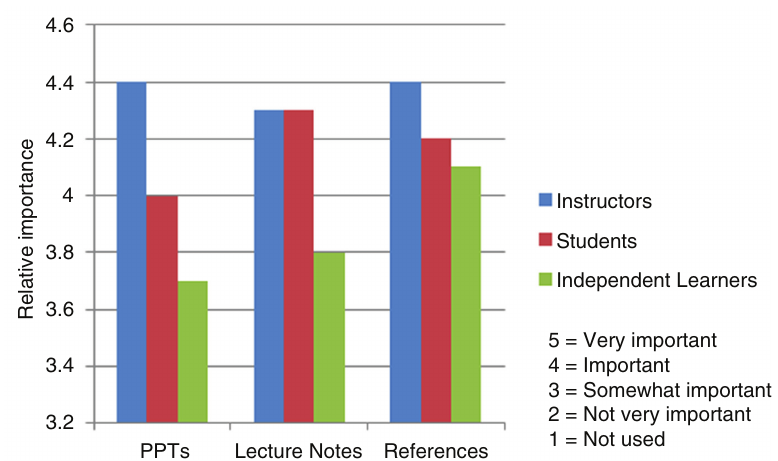
Figure 4. Instructors, students and independent learners have different priorities for the importance of the PowerPoint files, Lecture Notes and References provided in the Teaching Tools. Instructors particularly value the PowerPoint files as sources of images for teaching, the students rank the Lecture Notes as most important, and the independent learners rank the references as most